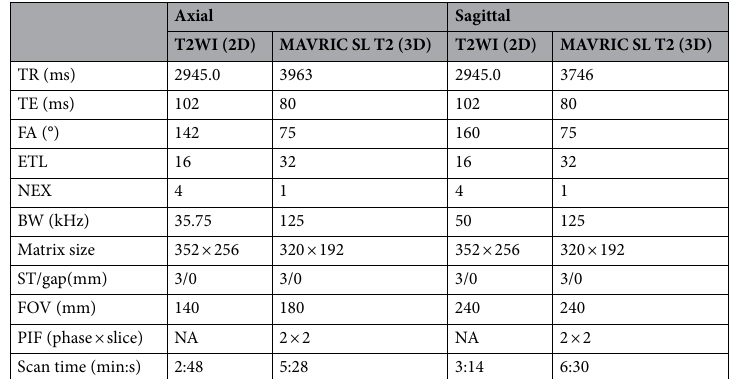
Table 4. MRI protocol of the volunteer study. 2D two dimensional, 3D three dimensional, TR repetition time, TE echo time, FA flip angle, ETL echo train length, NEX number of excitations, BW bandwidth, ST section thickness, FOV field of view, PIF paralled imaging factor, TI inversion time, T2WI fast spin echo T2-weighted sequence, MAVRIC SL T2 multiacquisition with variable resonance image combination selective T2-weighted sequence, NA not